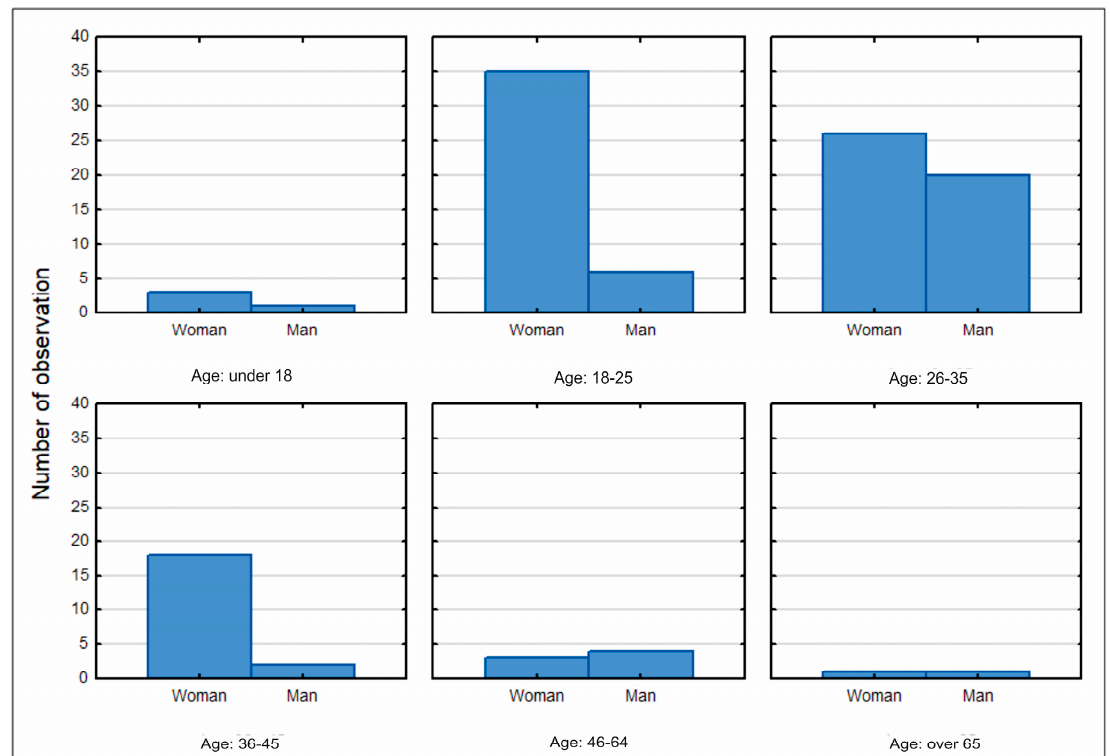
Figure 6. Histogram of the distribution of the survey respondents by gender and age. Source: own study based on questionnaire surveys.